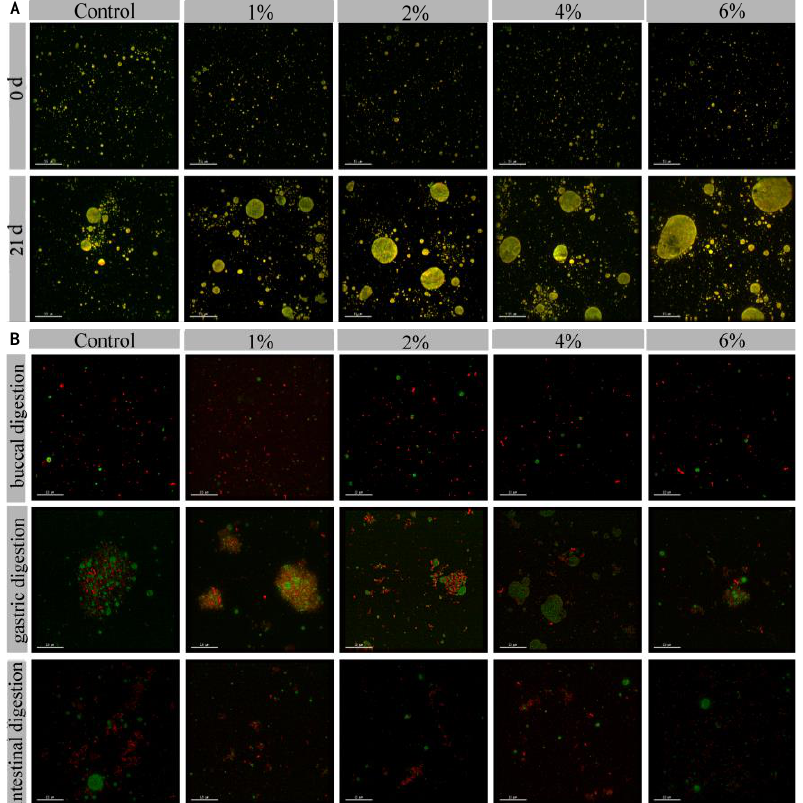
Figure 4. Microstructure of FGM supplemented with BHJ during storage on day 0 and after 21 days at 4 ◦ C ( A ) and during in vitro buccal, gastric and intestinal digestion ( B ) (green denotes fat and red indicates